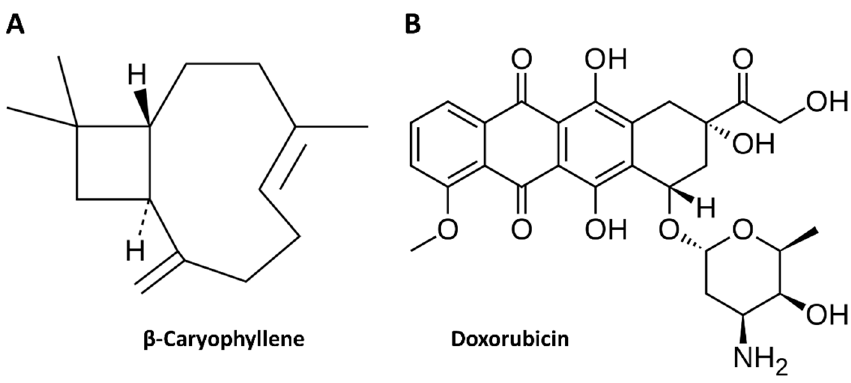
Figure 1. Molecular structure of the natural sesquiterpene β -caryophyllene ( A ) and the anticancer drug doxorubicin ( B ).